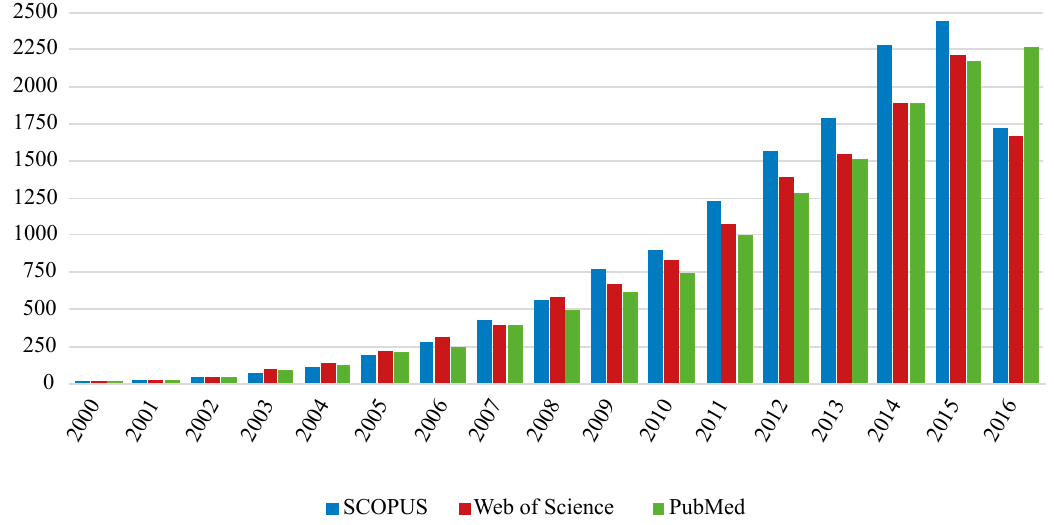
Figure 2. Number of publications per year using the key terms “metabolomics” or